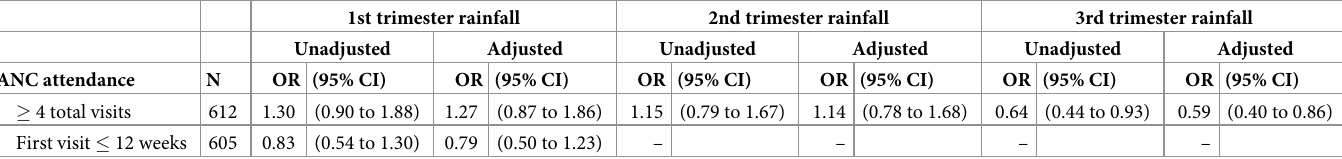
Data are odds ratios (OR) and 95% confidence intervals (CI) from logistic regression models of binary antenatal care (ANC) attendance outcomes regressed on average daily rainfall (binary: above vs. below sample average) for each trimester. Inverse probability of censoring weights were applied to all models to account for missing outcomes data. Adjusted models include maternal parity, HIV status, education, marital status, and pregnancy desire; father’s supportiveness of the pregnancy; and household income and distance to a main